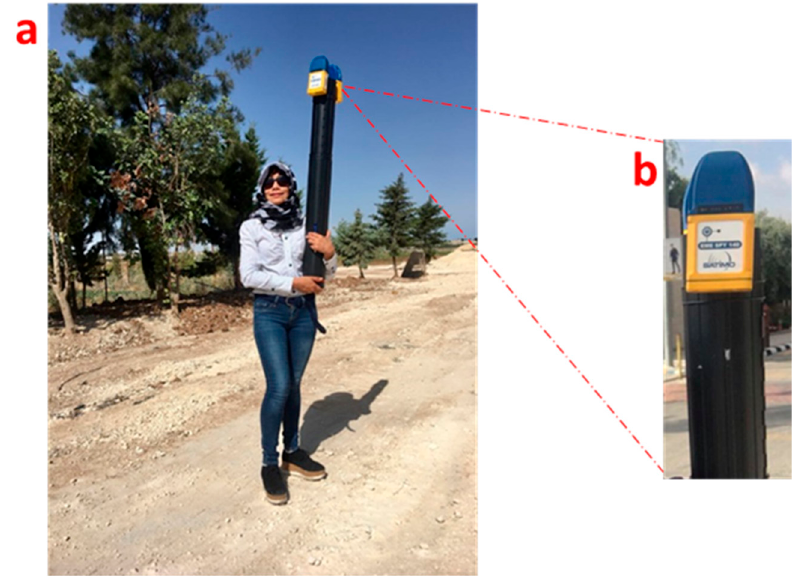
Figure 4. ( a ) Measurement method using two exposimeters placed above the head of the measurement researcher and ( b ) personal